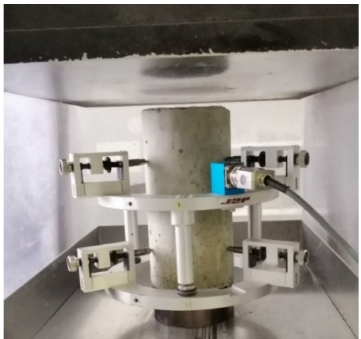
Figure 3. Testing arrangement for modulus of elasticity with